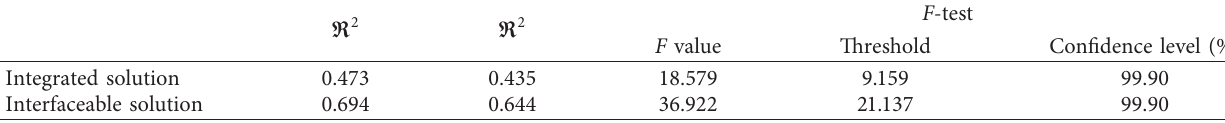
Table 6: Global statistical tests in the case of the BPR cost function.